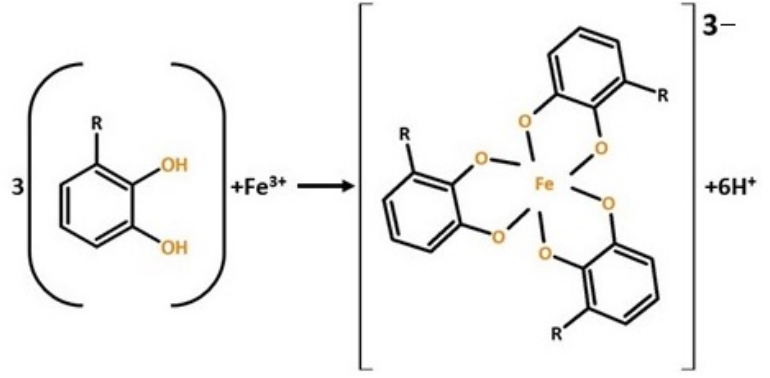
ying the antioxidant properties of the compounds. Such values are associated not only with the electron-transfer mechanism, but also with the mechanism of possible complex- ation with iron ions [12,42,59]. It is known that peroxides decompose with the formation of a highly reactive hydroxyl radical in the presence of metals of variable valence [60,61]. This process plays a key role in DNA damage. Polyphenolic compounds containing cate- chol or gall structures are able to form stable complexes with metals of variable valency and inhibit radical processes at the stage of chain branching (Scheme 2):